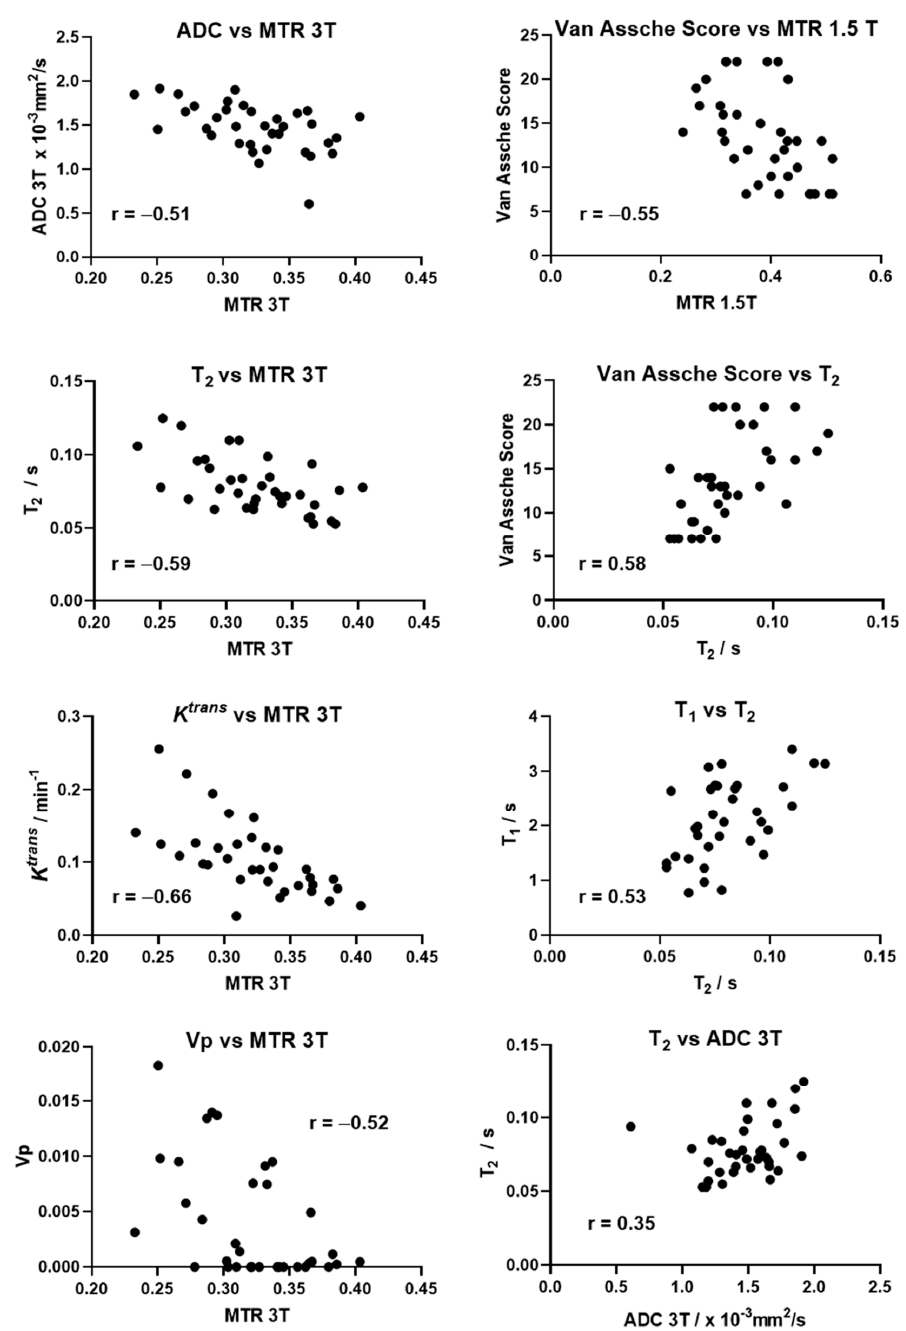
Figure 5. Graphs of correlation between some of the MRI quantitative parameters with the Pearson correlation coefficients shown on the graph.